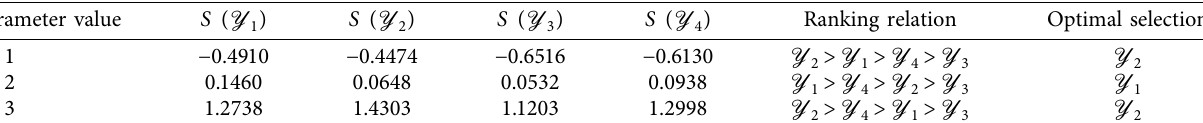
Table 9: Score index values and ranking of alternatives on the basis of different values of k .